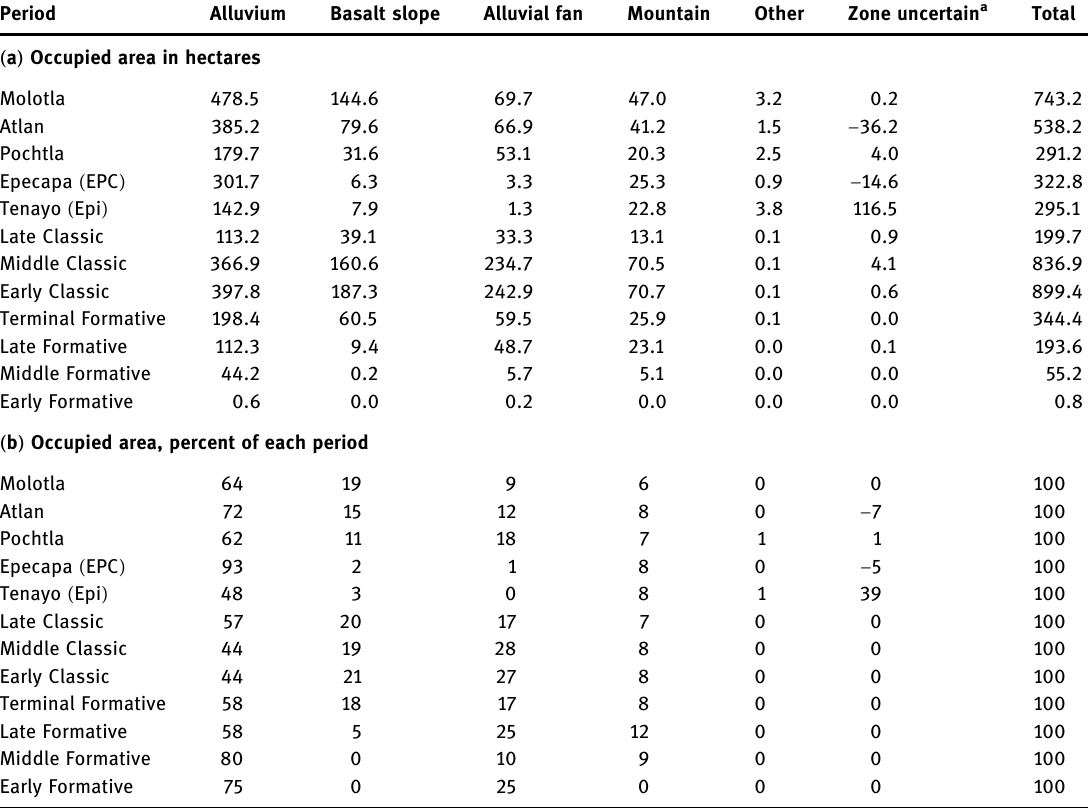
Table 5: Distribution of total site area ( population ) among environmental zones Period Alluvium Basalt slope Alluvial fan Mountain Other Zone uncertain